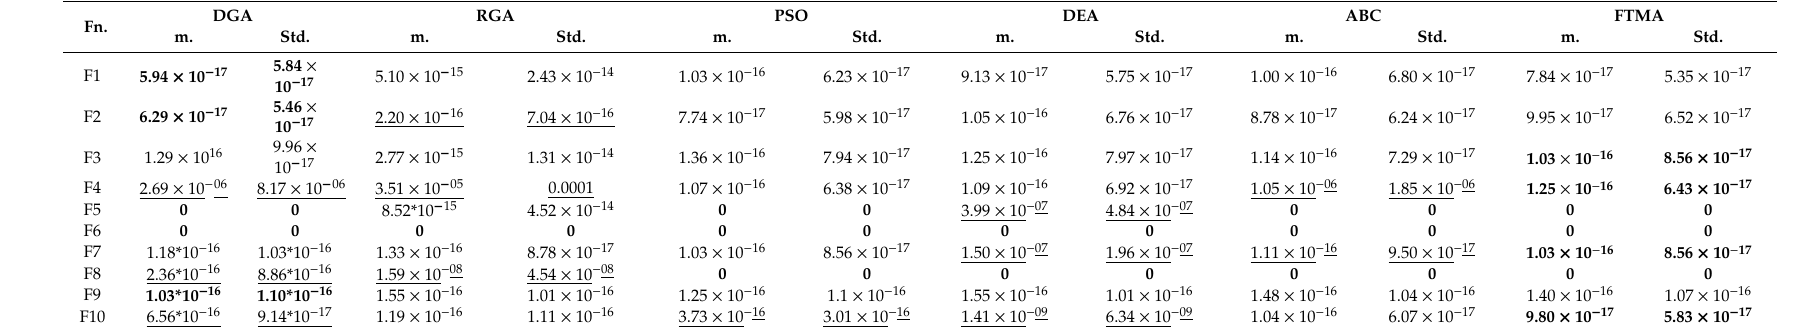
Table 4. Statistical results of the output error for 30 trials.